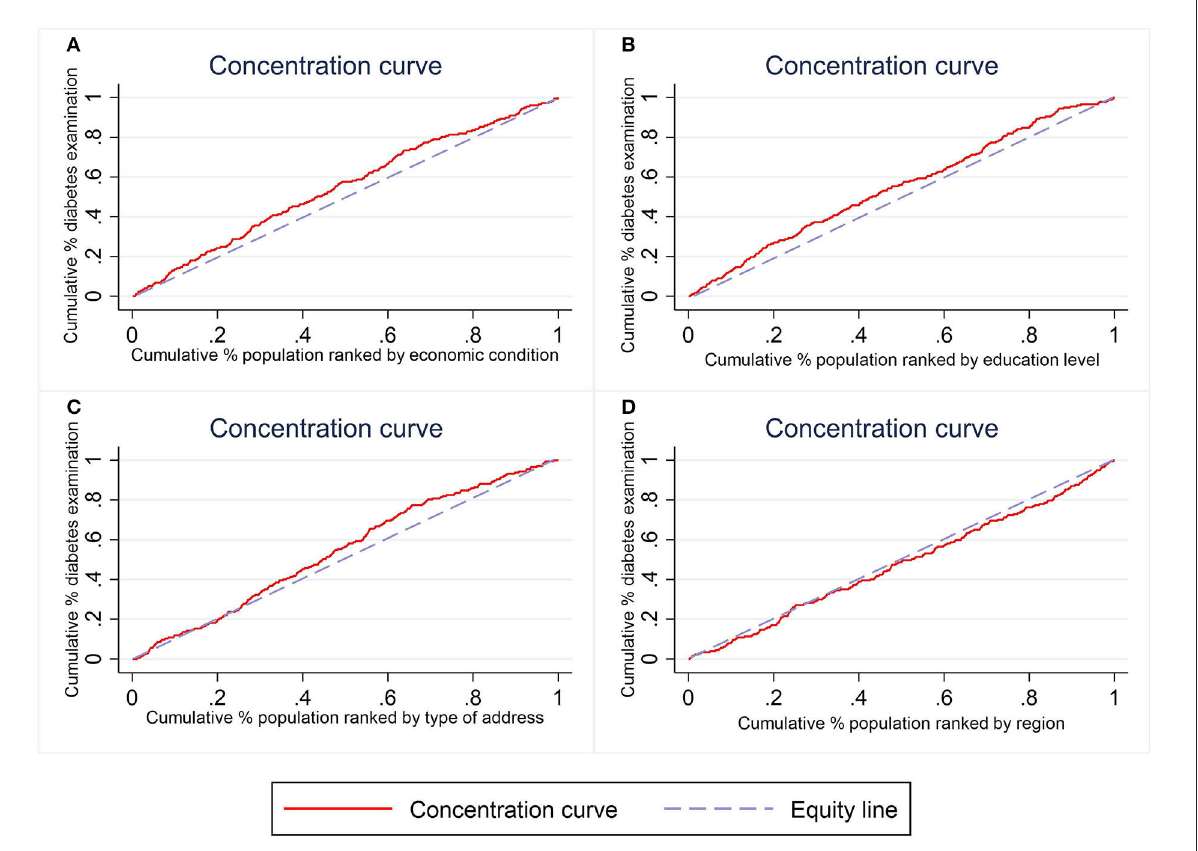
FIGURE2 Concentration curves of inequalities in community-based diabetes